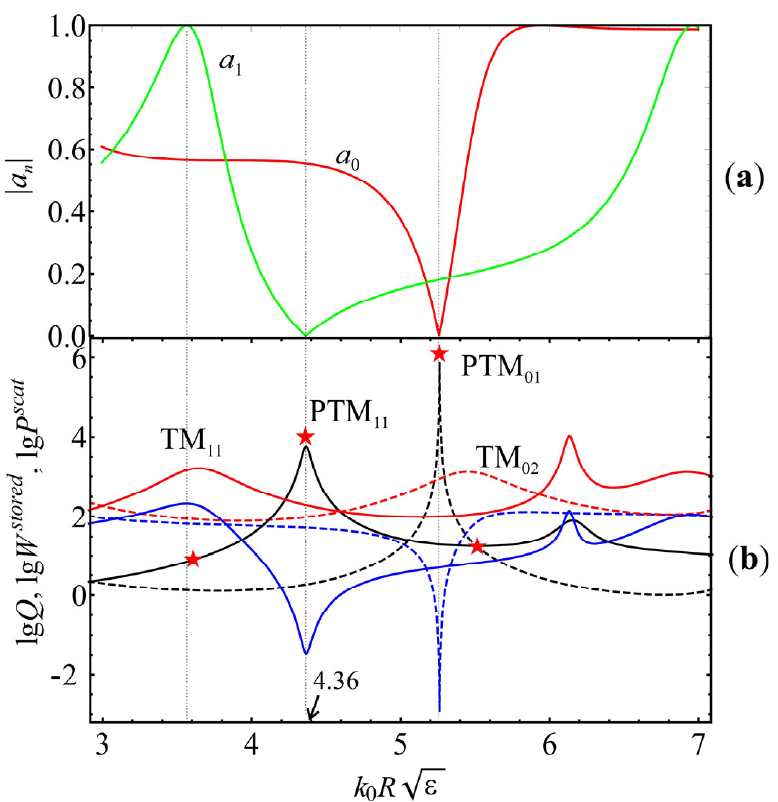
Figure 4. ( a ) Dependencies of the TM Mie coefficients | a 0 | and |a 1 | (see (14)) and ( b ) the scattered power lg P scat (blue curves), stored energy lg W stored (red curves), and radiation quality factor lg Q √ ε (black curves, (21)) on size parameter k 0 R ( ε = 12) for circular waveguide obtained with Comsol Multiphysics. The solid curves correspond to the excitation field (17) and the dashed curves correspond to the excitation field (18) at α = π /4. The asterisks on the black curves show the Q factor values for the usual quasi-normal TM modes and the perfect invisibility PTM modes. The vertical dashed lines show the position of the mode frequencies.